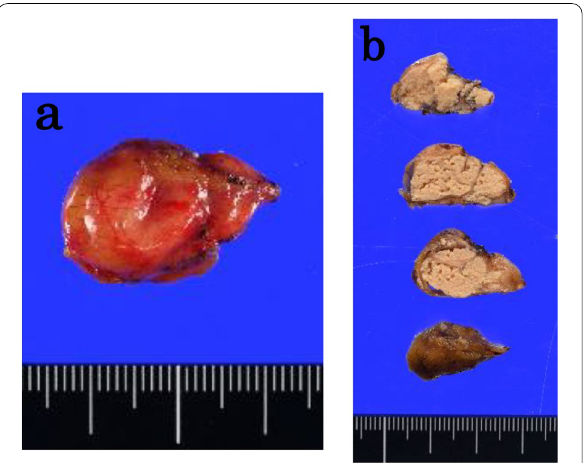
Fig. 3 Macroscopic pathological findings. a The resected tumor was round and 10 20 mm in size. b The growth was a multiloculated × cyst with a thin capsule containing a yellowish-white